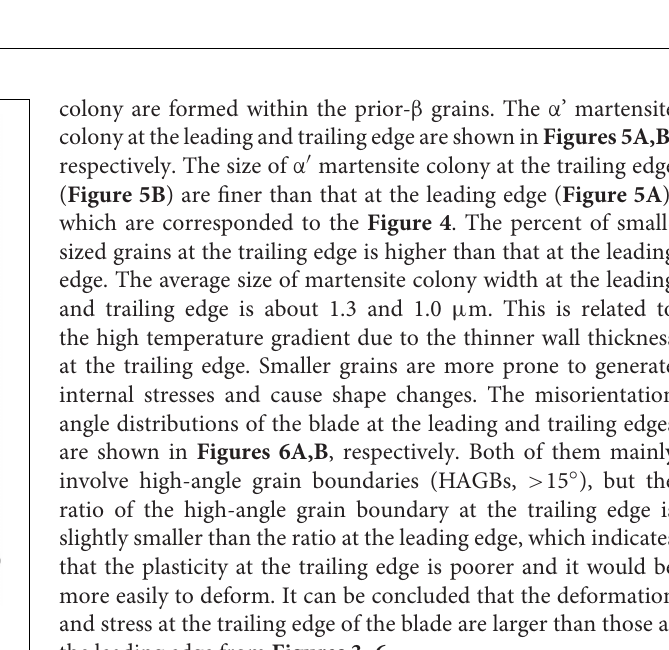
FIGURE 2 | The XRD profile for the SLMed Ti6Al4V blade